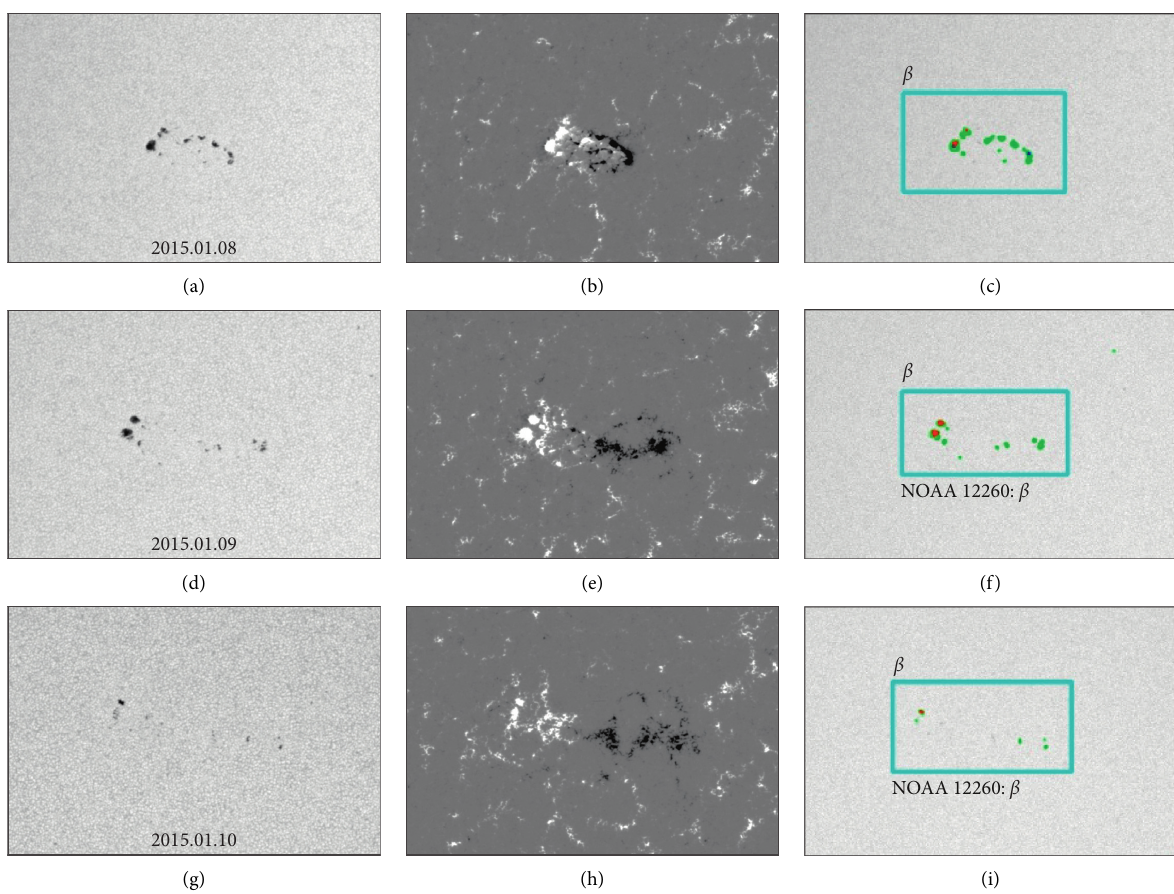
Figure 8: The classifications of NOAA 12660 given by our method and NOAA. The columns from left to right are the continuum image, magnetogram, and the classification result. The rows are the evolving procedure, which is on the 8th, 9th, and 10th of January 2015, respectively. All the times are 20:00:00 UT. The active region appeared on 8 January 2015. Our method detects the active region and classifies it into β in time. This AR is marked as NOAA 12260 and is classified into β on the 9th by NOAA.